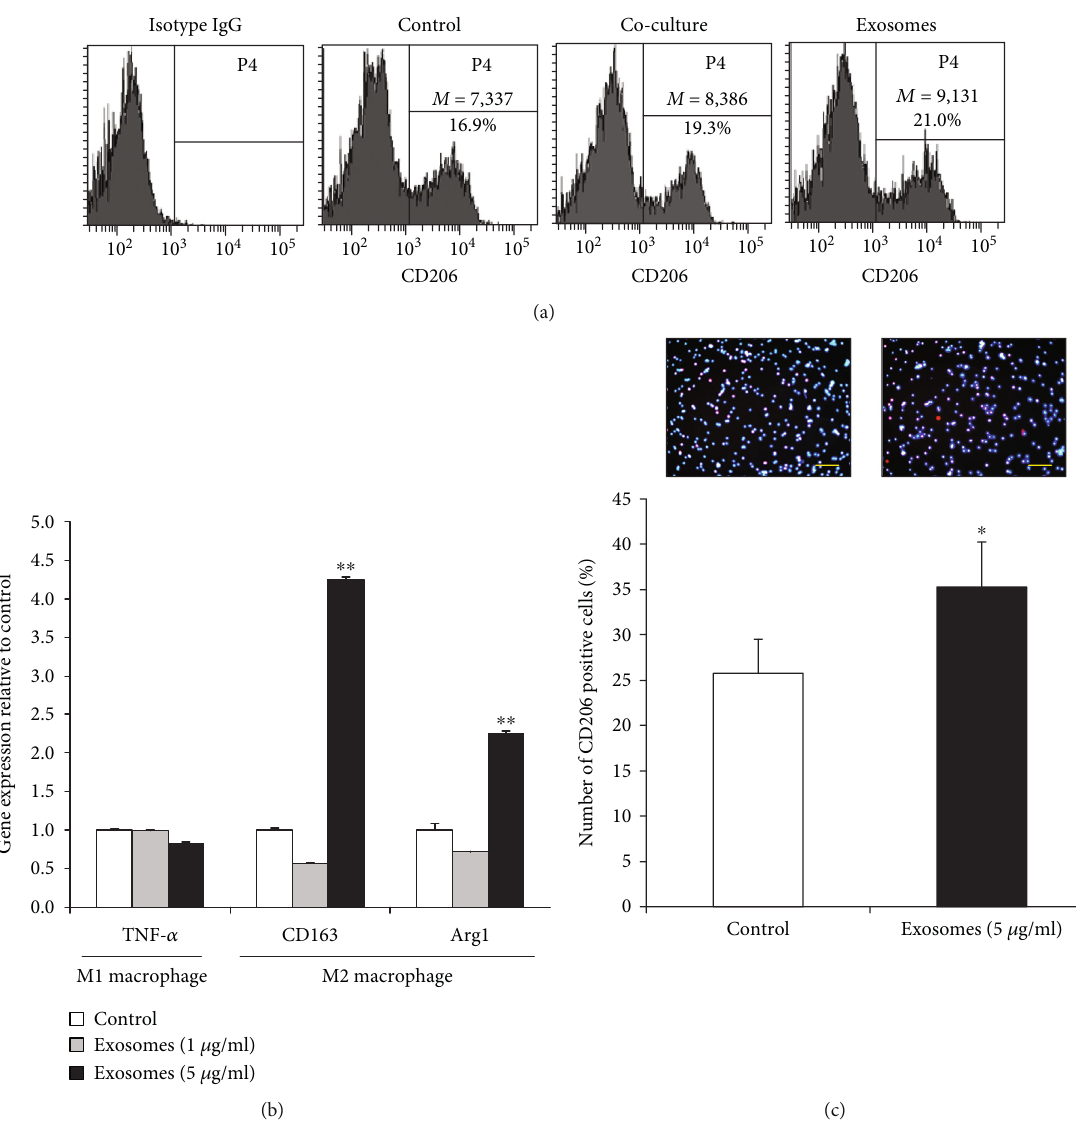
Figure 4: AdMSC-derived exosomes induce macrophage M2 polarization. (a) Expression of CD206 in PBMCs as assessed by fl ow cytometry. (b) qPCR analysis of PBMCs treated with 5 μ g/ml exosomes for 24h showed increased gene expression of CD163 and Arg1 (M2 macrophage markers). (c) M2 macrophage polarization by exosomes was con fi rmed by determining the percentage of CD206-stained cells ( scale bar = 100 μ m ). The data are expressed as the mean ± SD of three independent experiments. ∗ P < 0 : 05 , ∗∗ P < 0 : 01